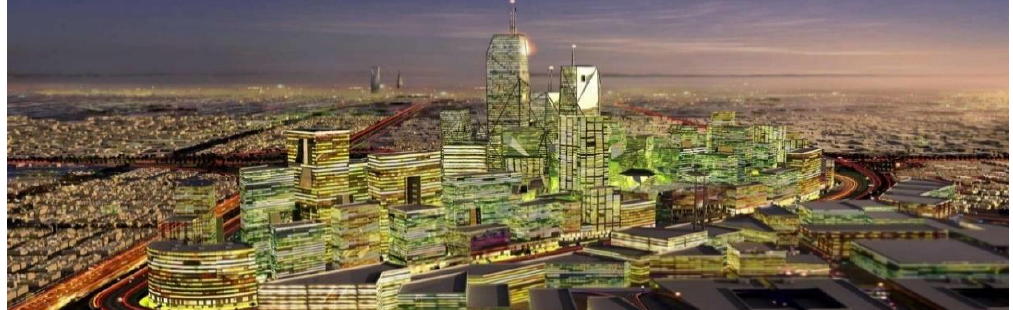
Figure 3: Saudi Arabia’s King Abdullah Financial